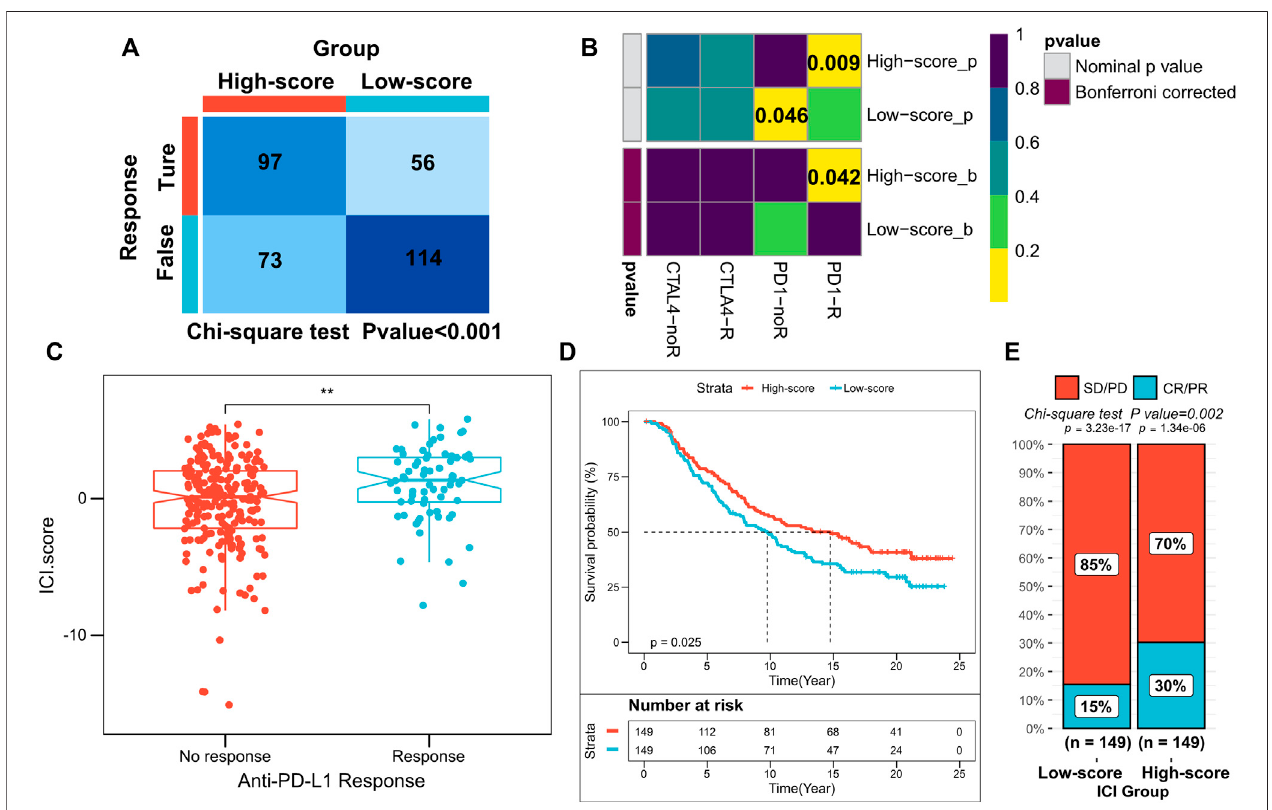
FIGURE 6 | Role of ICI scores in predicting the ef fi cacy of immunotherapy. (A) TIDE algorithm showing higher immunotherapy response in patients with high ICI scores, where p < 0.001 for the chi-square test; (B) Subclass mapping showing higher sensitivity to anti-PD1 treatment in patients with high-score subgroups (FDR (cid:1) 0.042); (C) ICIscoresforsubgroupswithdifferentanti-PD-1clinicalresponsestatus,where p < 0.01fortheWilcoxontest; (D) Kaplan-Meiercurvesforpatientswithhigh and low ICI scores in the IMvigor210 cohort, where p (cid:1) 0.025 for the log-rank test; (d) Clinical response rates to anti-PD-L1 immunotherapy in the high or low ICI score subgroups in the IMvigor210 cohort [complete response (CR)/partial response (PR) and stable disease (SD)/progressive disease